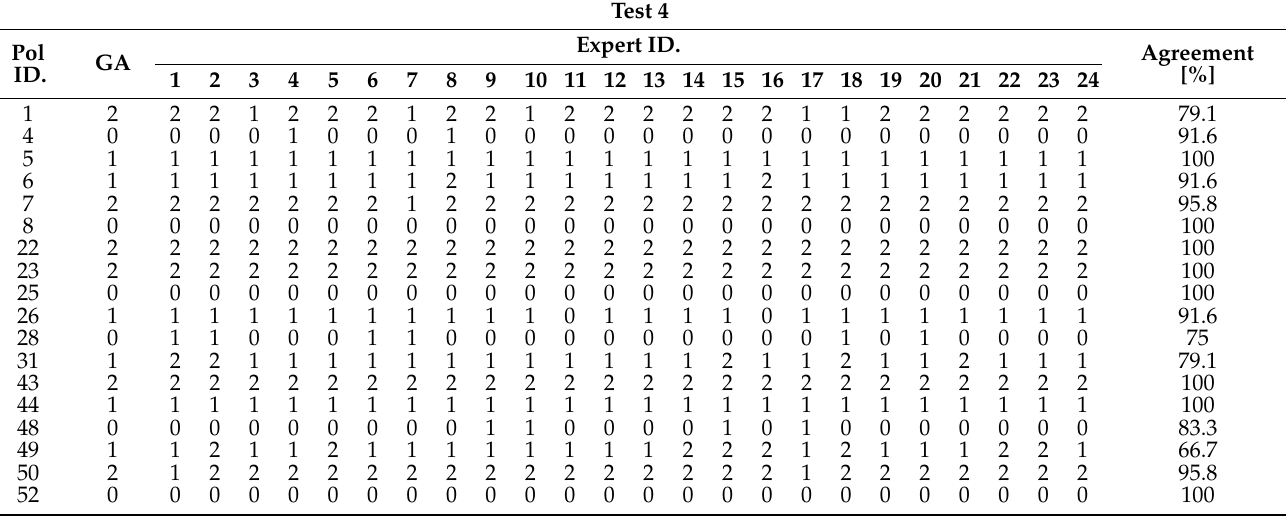
Table A3. Results provided by the Experts vs GA. MAV Experiment (Test